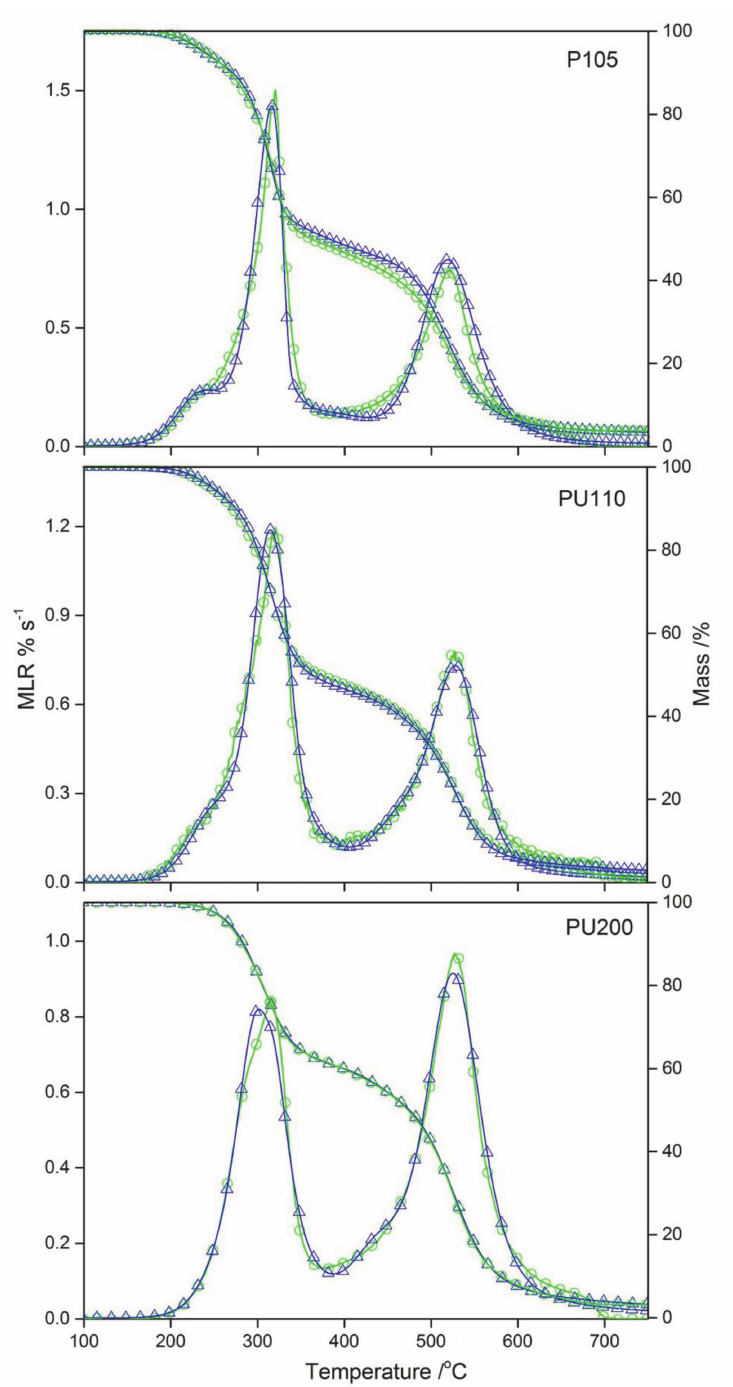
Figure 3. Experimental data (blue) and predicted results (green) of P105, 110, and 200 degradations in the air atmosphere at 10 ◦ C min − 1 heating